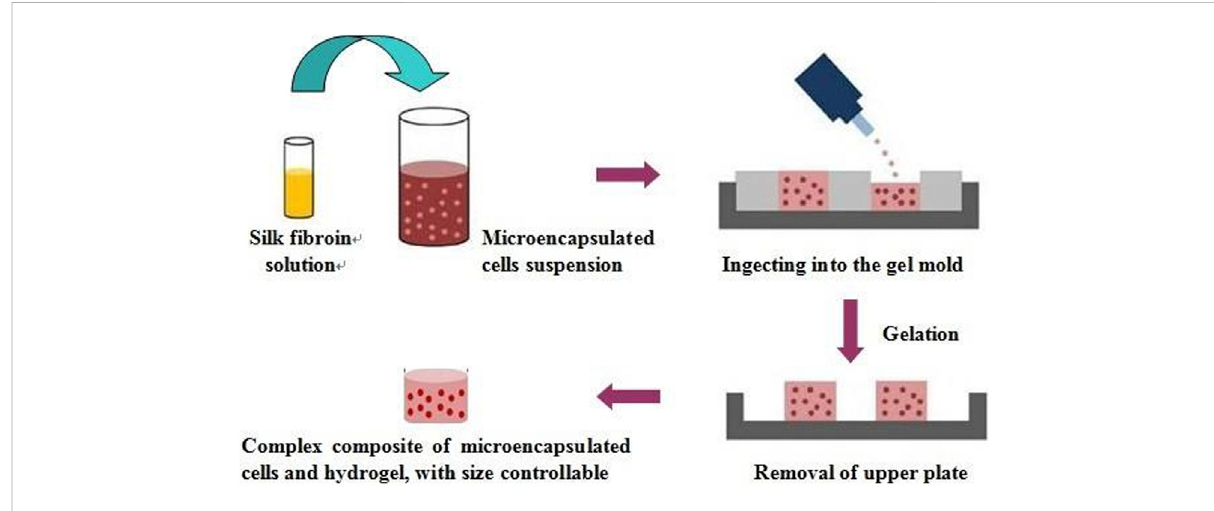
SCHEME 2 The preparation process of the silk fi broin gel and cell microcapsulation